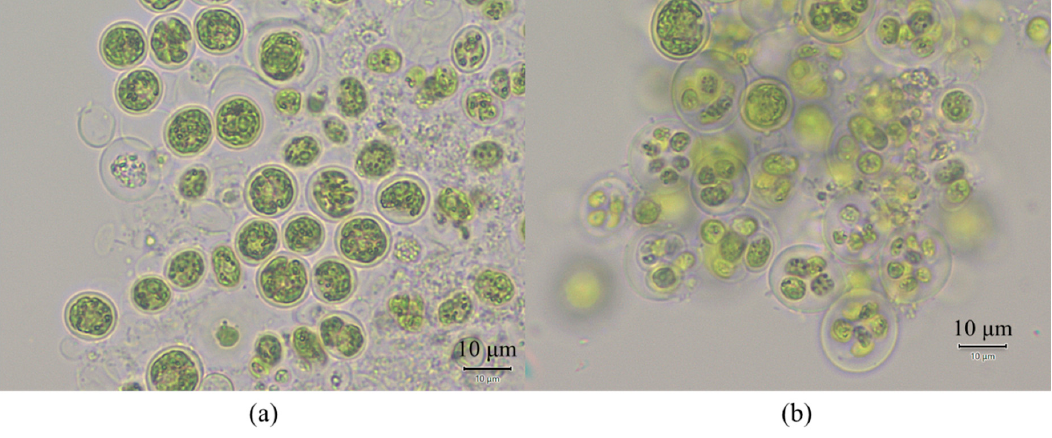
Figure 9. M. aeruginosa cells. ( a ) before and ( b ) after treatment using Al electrode. The scale bar is 10 μ m (captured using a BZ-X810 fluorescence microscope at 44.4× magnification).